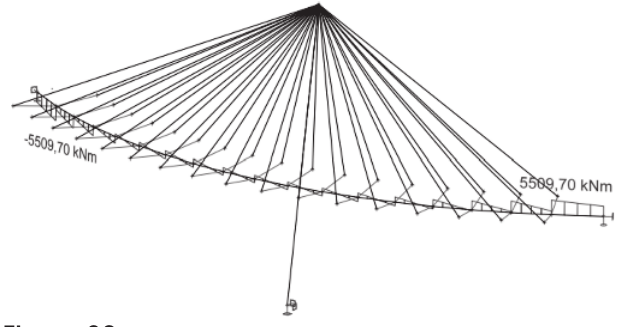
Figure 32 Torsional moment on curved deck (P): bilateral case